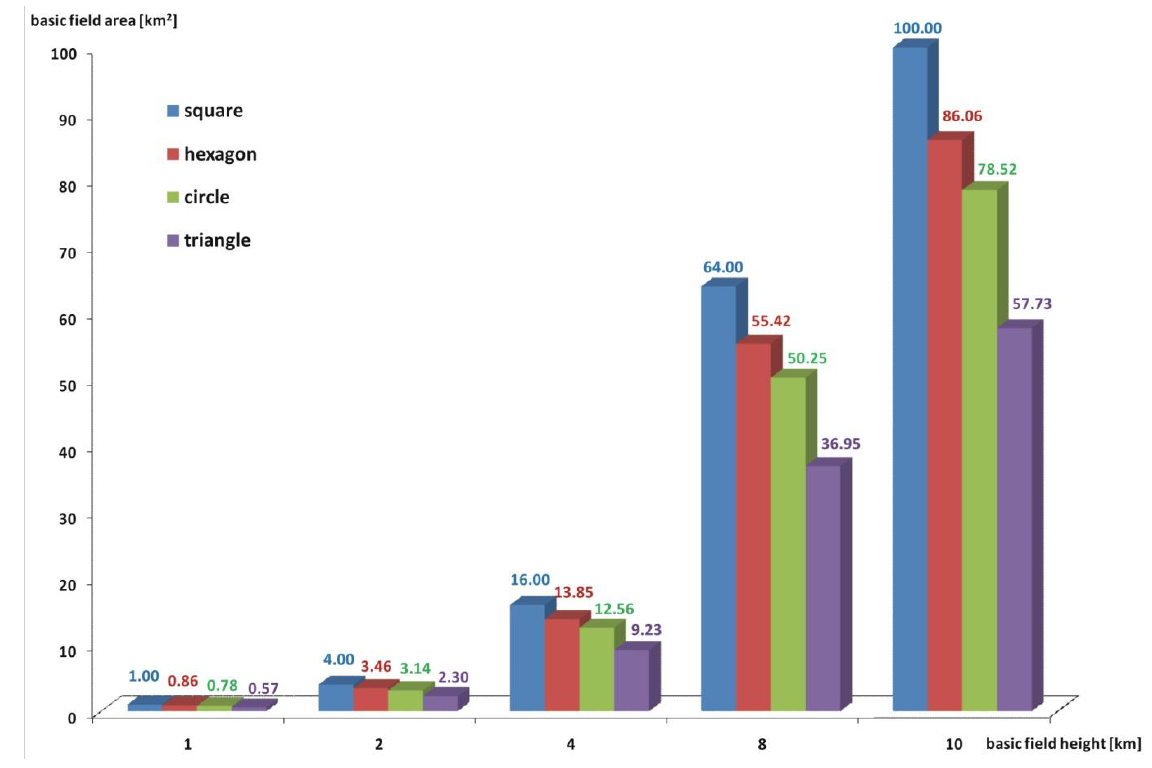
Fig. 6. Basic fields sizes and